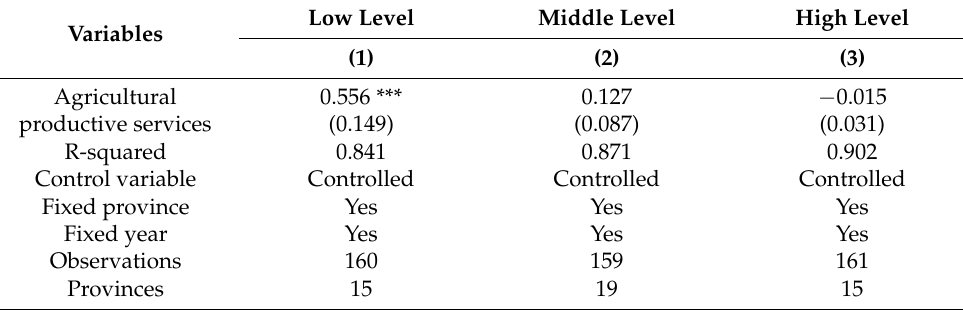
Table 7. Heterogeneity impact of different levels of productive agricultural